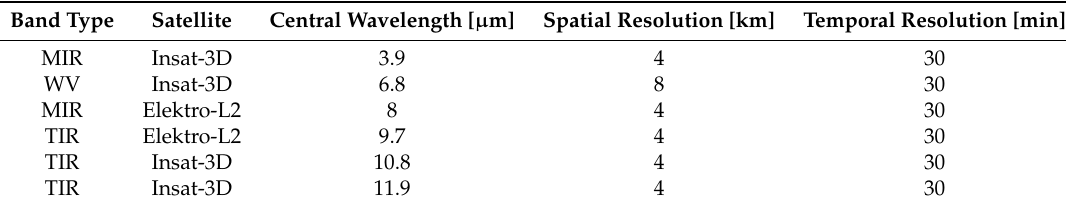
Figure 1. Data availability of the least common data of Insat-3D, Elektro-L2 and GPM IMERG (with all met conditions) for the half year of 2017 on a temporal ( a ) and spatial ( b ) scale relative to the number of available scenes. Table 1. Overview of used bands derived from Insat-3D and Elektro-L2. (MIR = Mid-Infrared; WV = Water Vapor, TIR = Thermal